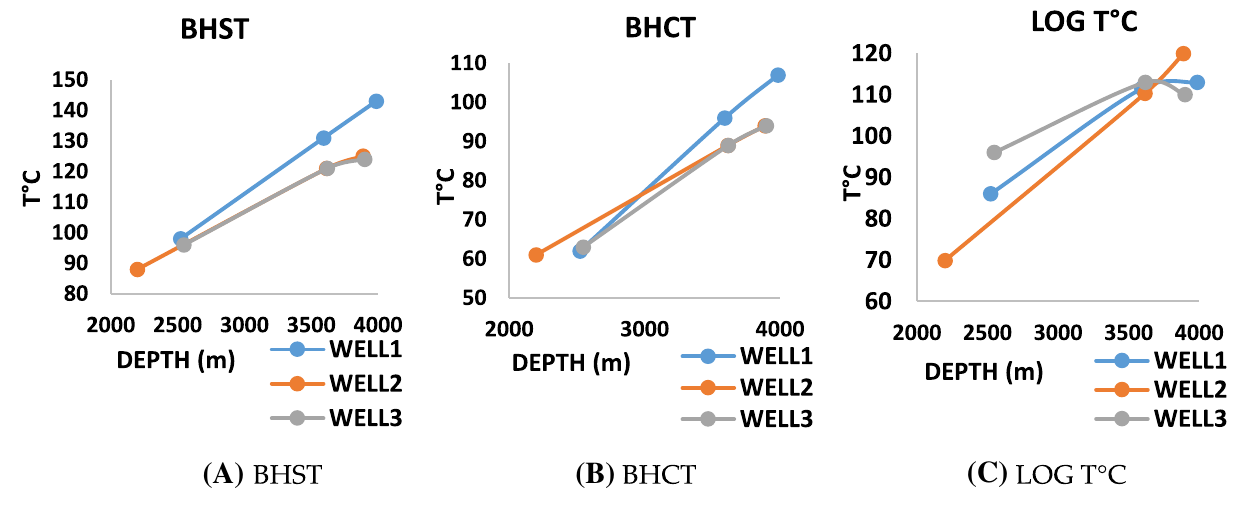
Fig. 3 Influences of down-hole temperature variation